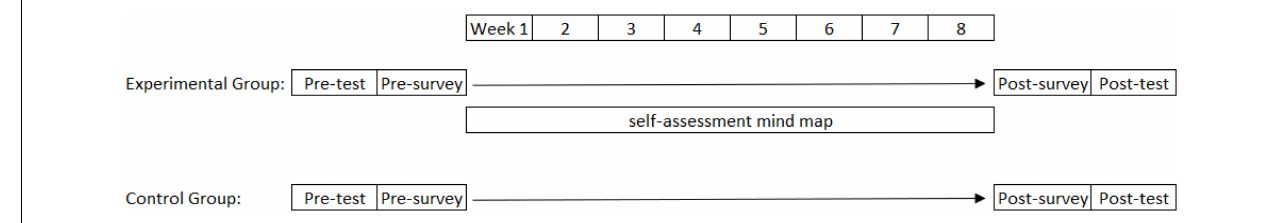
FIGURE 1 | The research